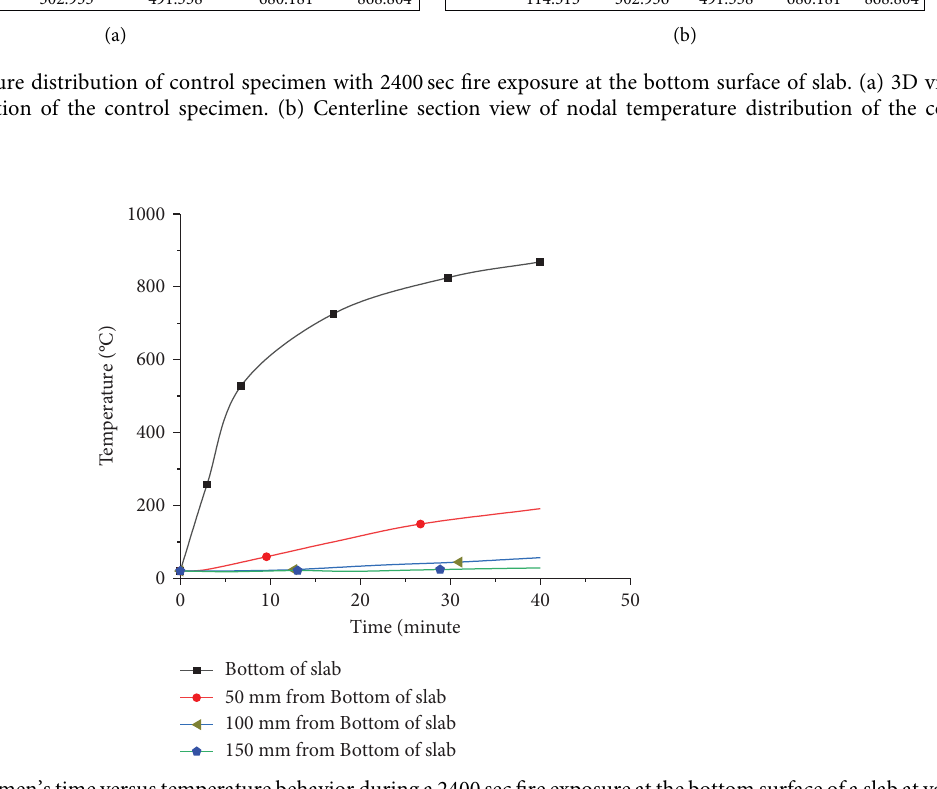
Figure 31: Te control specimen’s time versus temperature behavior during a 2400sec fre exposure at the bottom surface of a slab at varying slab